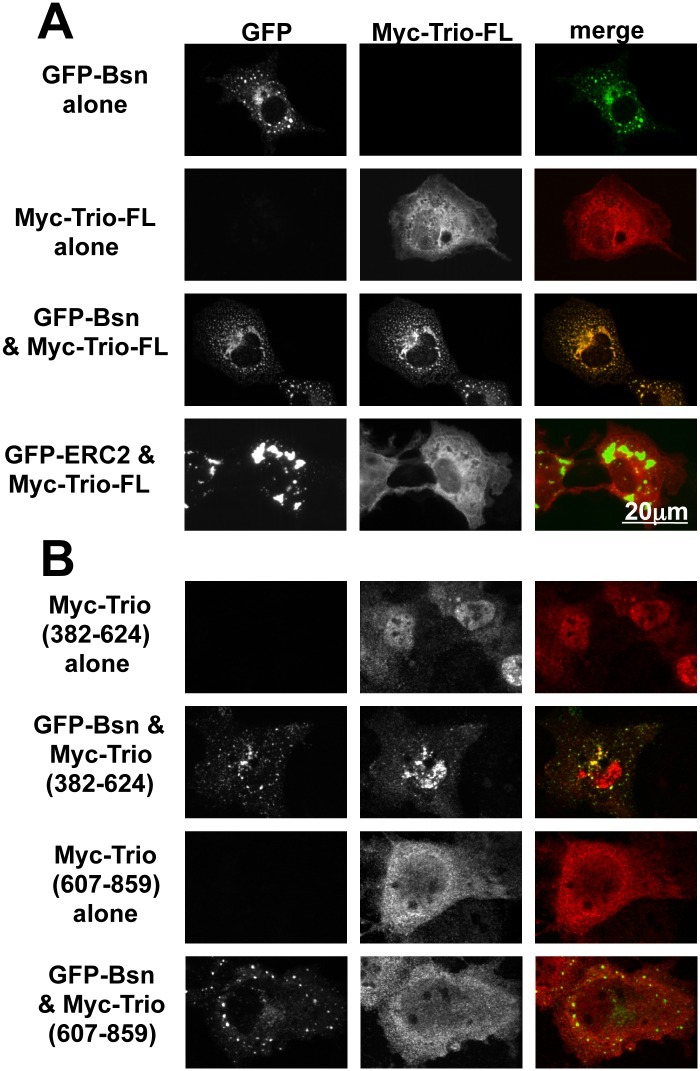
Spectrin repeats 3 and 4 of Trio mediate binding to Bassoon.(A) Examples of COS7 cells co-transfected with full-length (FL) Myc-tagged Trio-FL (red) and GFP tagged Bassoon (GFP-Bsn) or GFP-ELKS2 (green), used to evaluate binding interactions between these proteins. Note that GFP-Bsn effectively clustered Myc-Trio-FL. (B) COS7 cells co-transfected with Myc-tagged Trio polypeptides (red) and GFP-Bsn (green), used to evaluate which domain of Trio mediate binding to Bassoon. Note that Myc-Trio (382–624) clustered with GFP-Bsn, while Myc-Trio (607–859) did not.